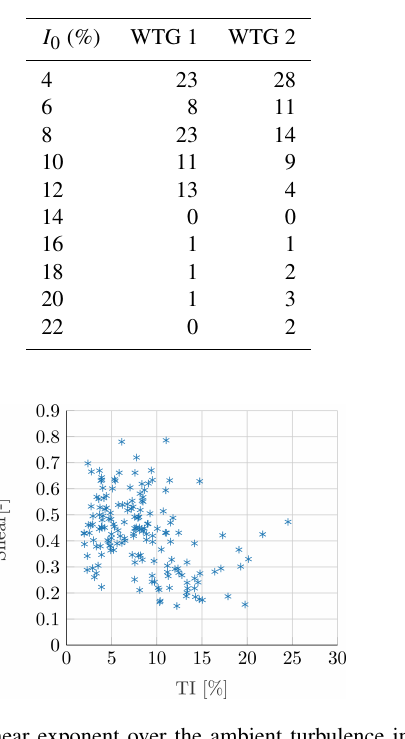
tensity is binned in 2 ◦ steps. Column 1 of Table 2 specifies Table 2. Number of measured and considered data sets per turbu- lence intensity for the lidar systems on WTG 1 and WTG 2.